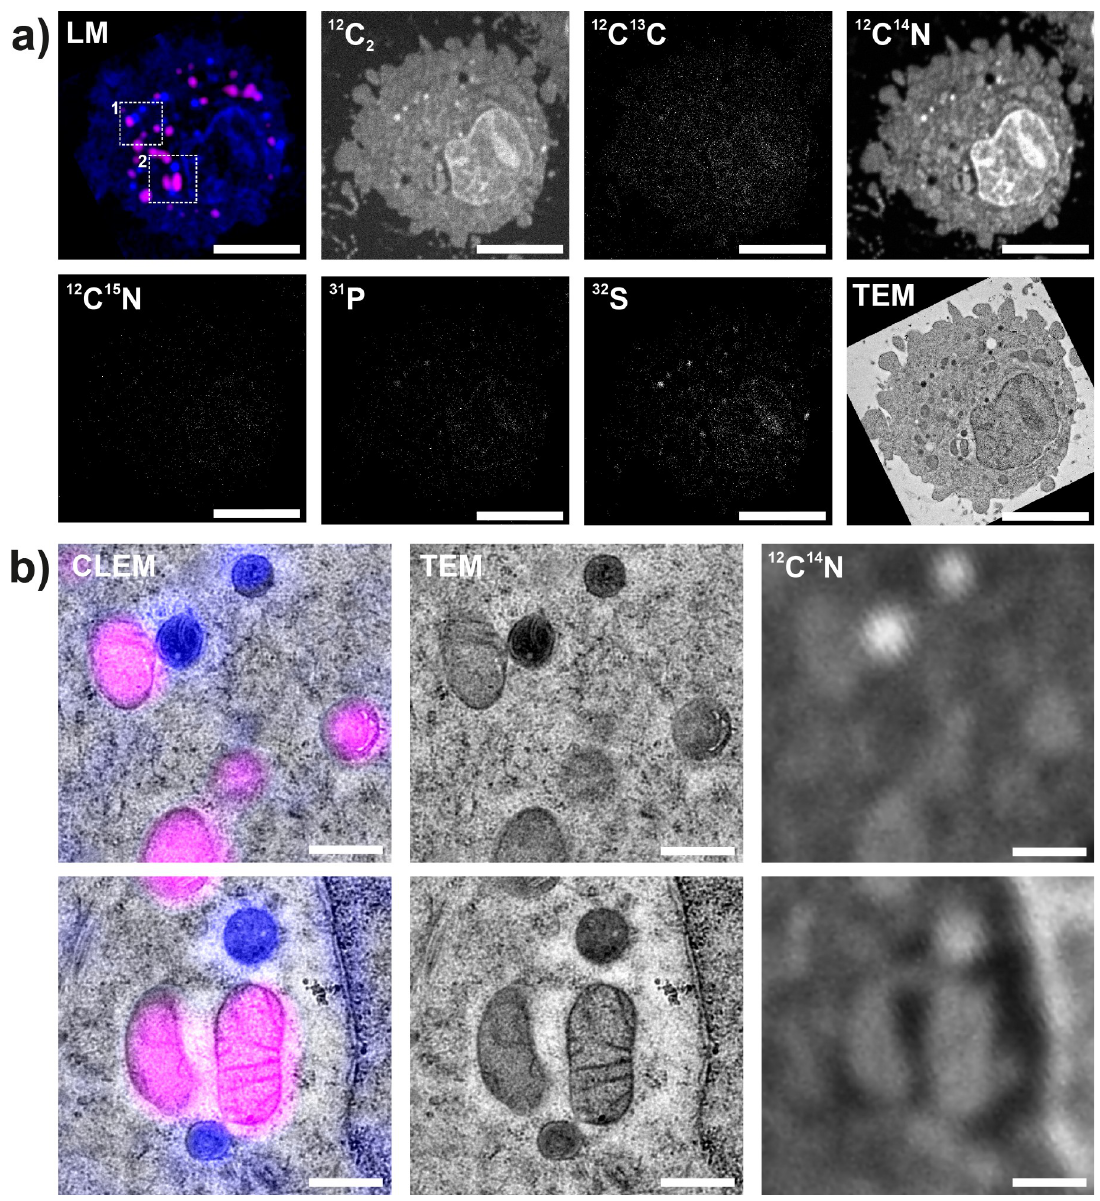
Fig 3. Detailed views of CLEM-SIMS in cell culture. a) An individual cell was imaged in light microscopy, TEM, and nanoSIMS. The fluorescence channels show the uranyl acetate fluorescence (blue) and the MitoTracker fluorescence (magenta). The measured isotopes are indicated in the different nanoSIMS images. Nitrogen isotopes ( 14 N, 15 N) are measured as CN - ions, while carbon isotopes ( 12 C, 13 C) are measured as C 2- ions. 13 C and 15 N are rare isotopes, which explains the low intensity of the respective images. Scale bars: 2 μ m. b) Higher zoom views of the areas marked by white squares in panel A. Correlations of fluorescence (light) microscopy (left panels), TEM (middle panels) and nanoSIMS (right panels, 14 N) are shown. Scale bars: 500